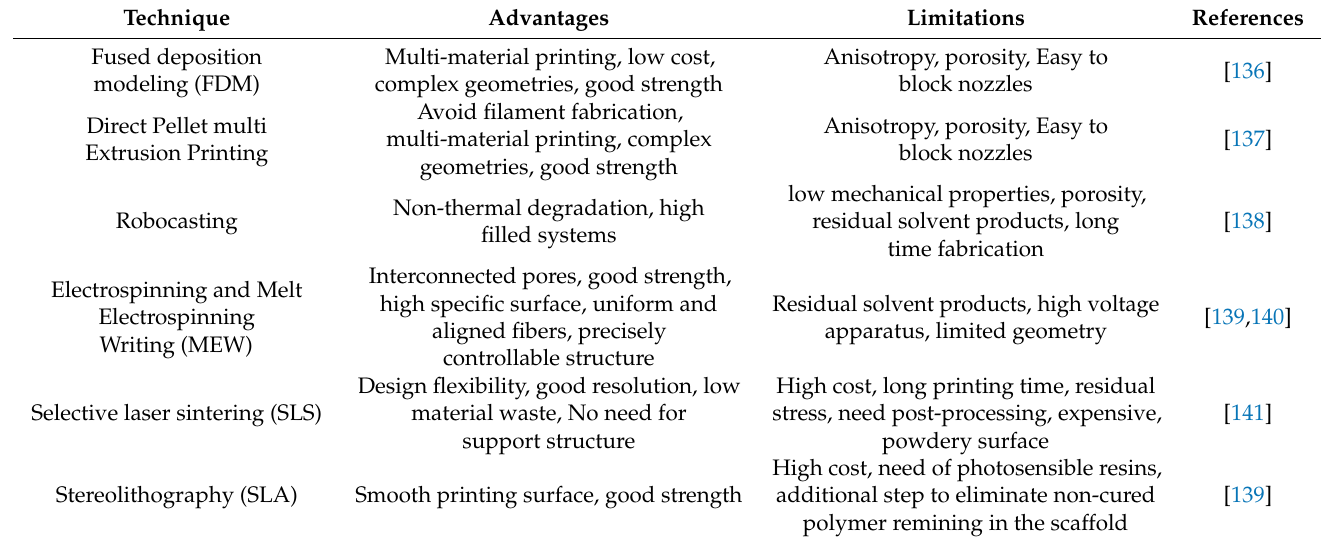
Table 3. Advantages and disadvantages of additive manufacturing processes and commonly used materials in tissue